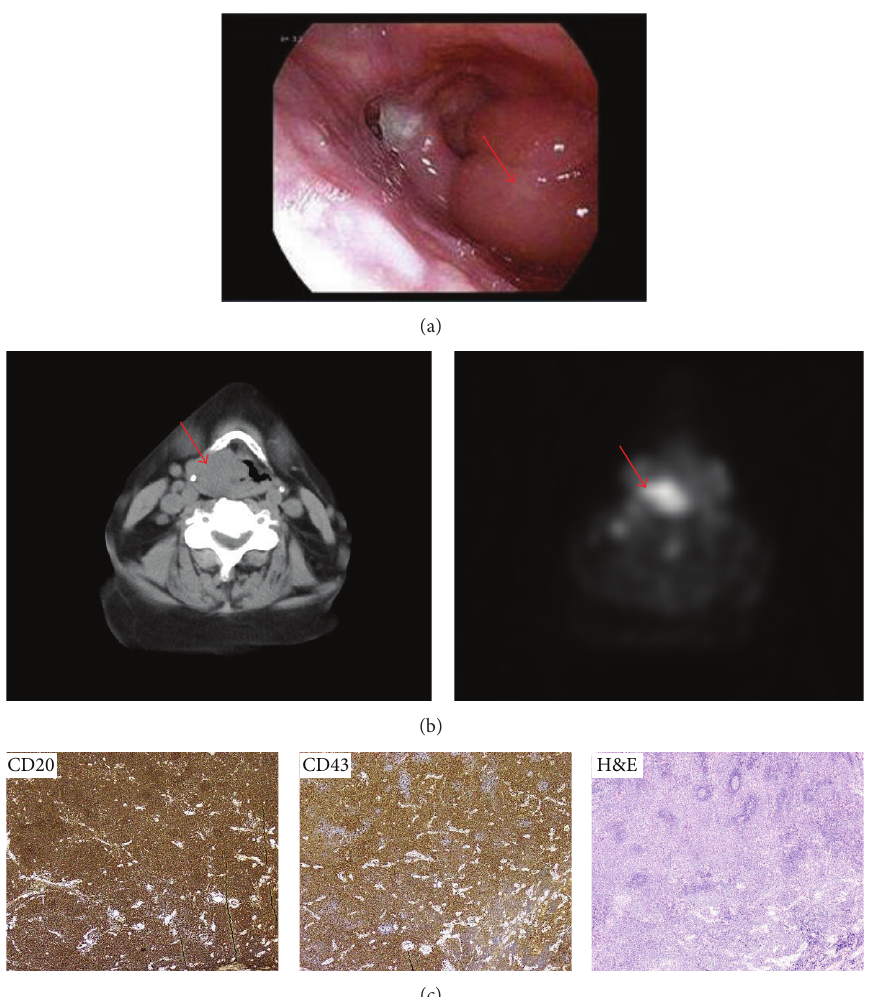
Figure 2: Laryngeal MALT lymphoma. (a) A 3 cm mass arising from the right aryepiglottic fold obscuring view of the right vocal cord on fiberoptic examination (red arrow). (b) PET/CT demonstrates a PET-avid exophytic mass arising from the right false cord (red arrow). (c) Immunohistochemistry: high power view (40x) anti-CD20, anti-CD43, and H&E: dense lymphocytic infiltrate and scattered small reactive- appearing follicles are seen surrounded by diffuse sheets of neoplastic marginal zone